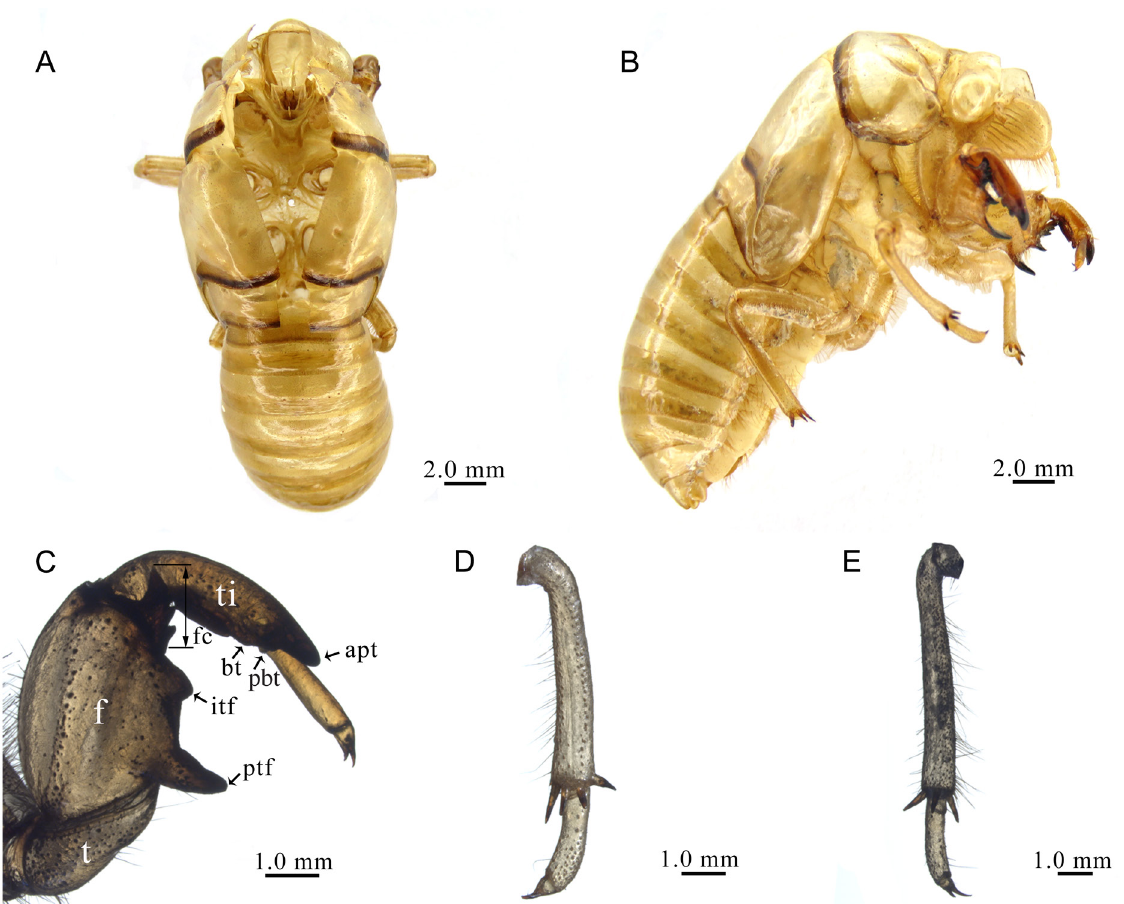
Fig. 4. Subpsaltria yangi Chen, 1943 (♂, exuvia). A . Dorsal view of body. B . Lateral view of body. C. Right fore leg, outer view. D . Spines at the apex of mid tibia. E . Spines at the apex of hind tibia. Abbreviations: apt = apical tooth of tibia; bt = blade of tibia; f = femur; fc = femoral comb; itf = intermediate tooth of femur; pbt = point of blade of tibia; ptf = posterior tooth of femur; t = trochanter; ti =